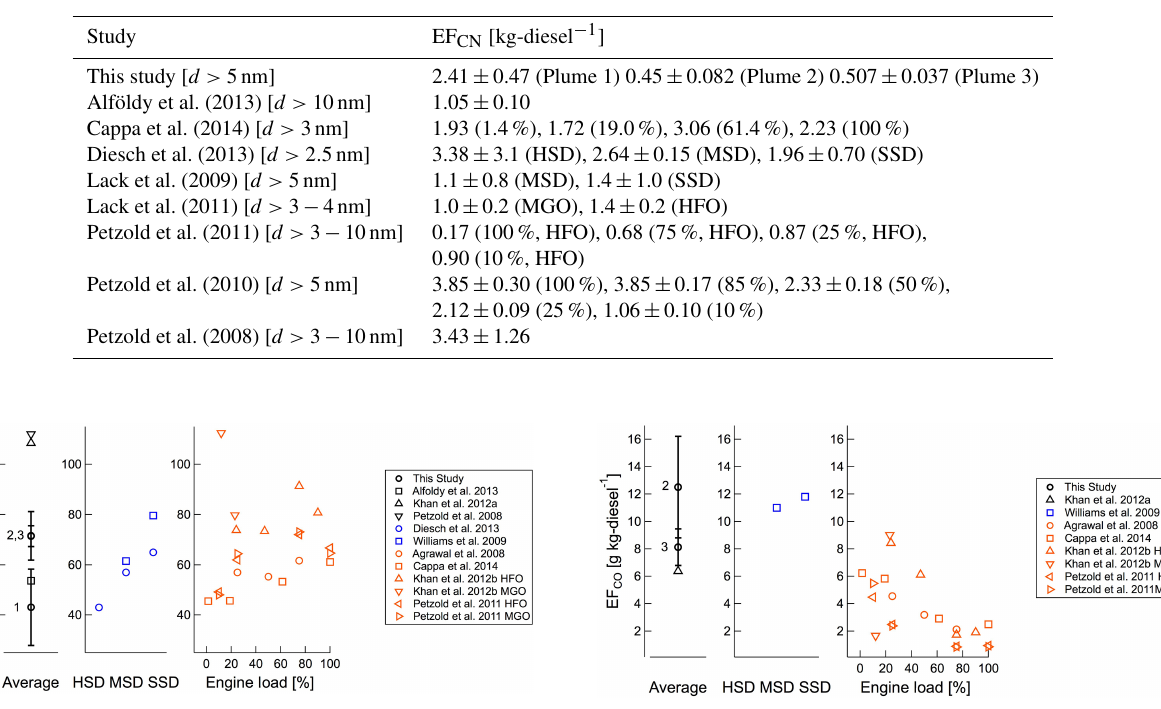
Figure 12. Emission factors for NO x ; fuel type (HFO: heavy fuel oil with high sulfur content, and MGO: marine gas oil with low sul- fur content), or vessel class based on gross metric tonnage (HSD: high speed diesel < 5000t, MSD: medium speed diesel 5000– 30000t, or SSD: slow speed diesel > 50000t); plumes 1, 2, and 3 are indicated on the plot with numbers 1, 2, and 3 and the estimated uncertainty is shown by error bars.